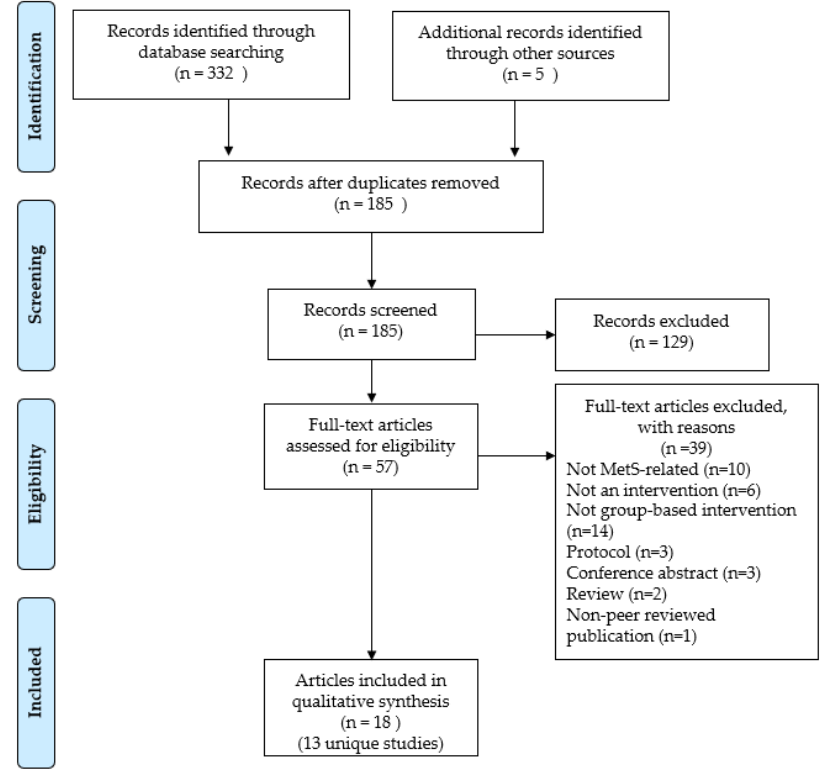
Figure 1. PRISMA flow chart showing the study selection process.